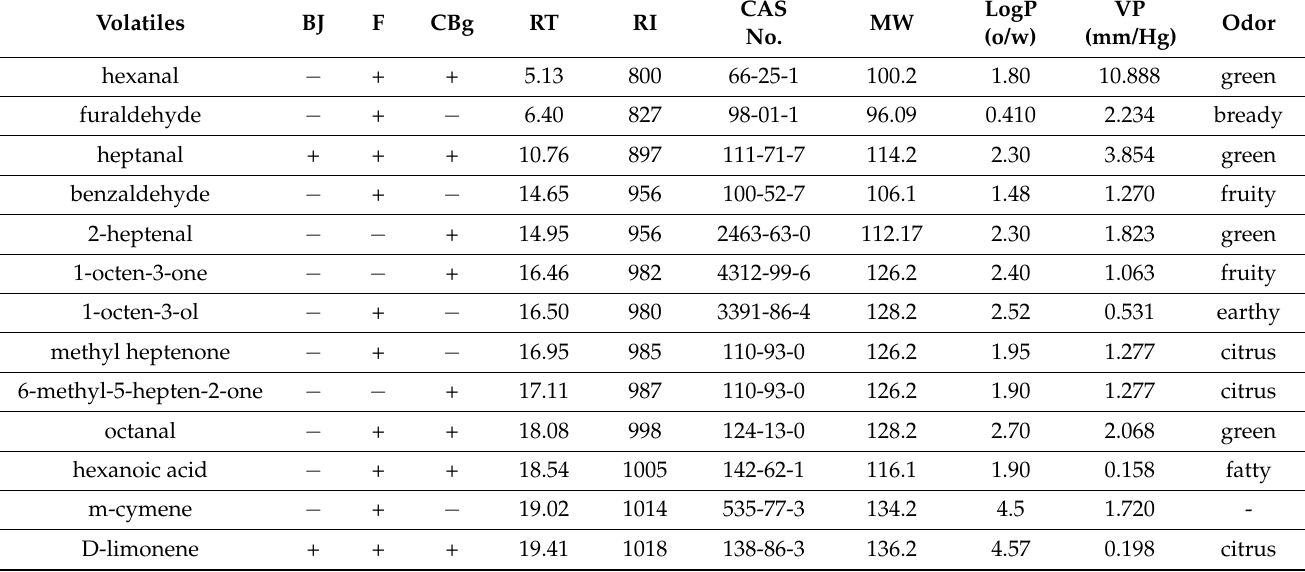
Table 1. Volatile compounds identified in blackberry juice (BJ), citrus fiber (F) and citrus fiber/blackberry gels (CBg), and their